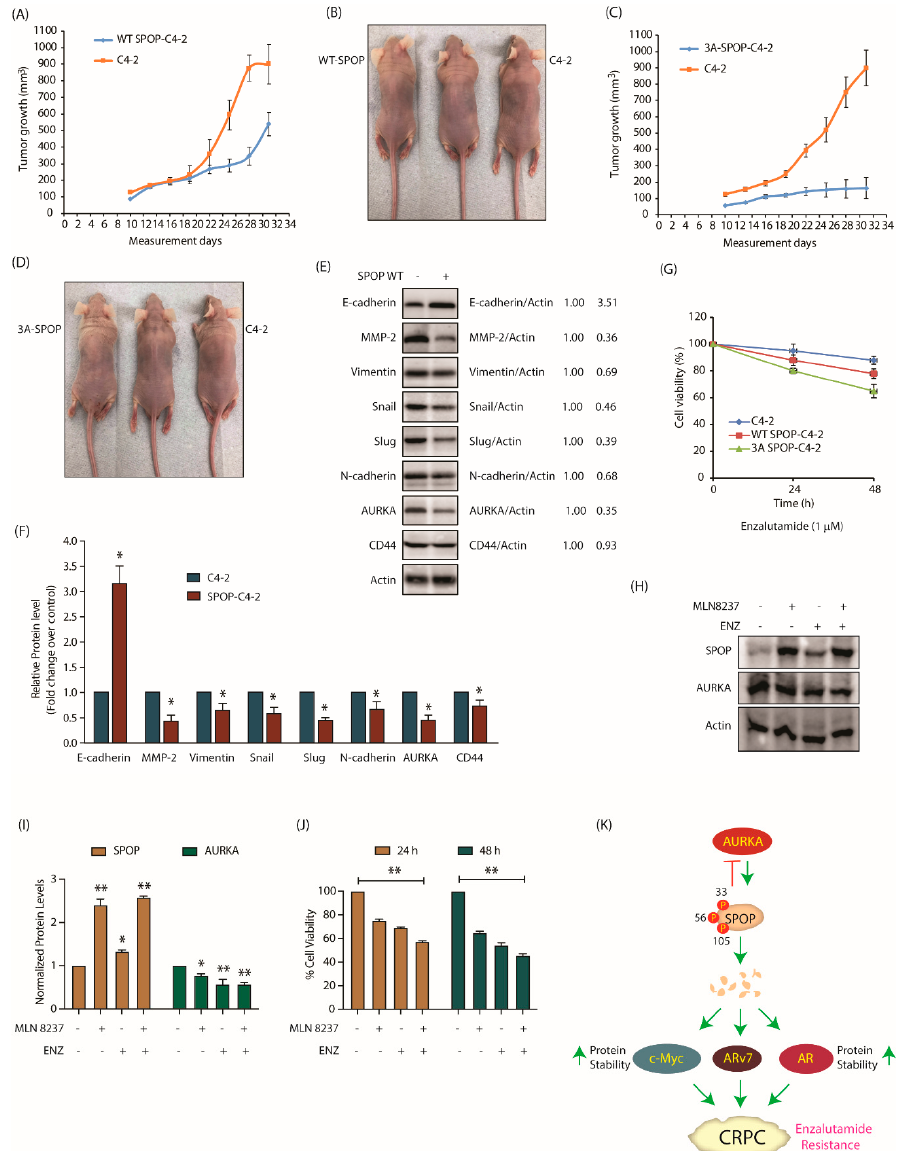
Figure 8. SPOP degradation by AURKA promotes tumorigenesis, EMT and enzalutamide-resistance. ( A ) SPOP overexpression prevents tumor growth in vivo. Growth curves of tumor in nude mice inoculated with C4-2 and SPOP-C4-2 cells on right and left shoulders, respectively. The mean value ± SEM values were from three animals in each group. ( B ) Representative images of tumor bearing nude mice. Pictures were taken 32 days after injection. ( C ) Growth curves of tumor obtained from nude mouse injected with C4-2 and 3A-SPOP-C4-2 cells. ( D ) Representative image showing mouse with tumor. The pictures were taken 32 days following inoculation. ( E ) Expression of EMT markers in tumor tissues obtained from C4-2 and SPOP-C4-2 cells injected in mice. ( F ) Histogram shows expression levels of EMT markers in tumor isolated from C4-2 and SPOP-C4-2 injected mice. The data are presented as mean ± SEM values collected from three independent experiments. * p < 0.05 was analyzed using two-way ANOVA. ( G ) 3A-SPOP-expressing cells are more sensitive to enzalutamide (1 µ M, treated for 48 h), compared to WT-SPOP-C4-2 cells. ( H ) Changes in SPOP levels with treatments of MLN8237 (1 µ M, treated for 12 h), and enzalutamide (1 µ M, treated for 12 h). ( I ) Quantification of protein levels as a function of drug treatment obtained from three independent experiments, * p < 0.05, ** p < 0.01. ( J ) Loss of cell viability with treatments of MLN8237 (1 µ M, treated for 24 and 48 h), and enzalutamide (1 µ M, treated for 24 and 48 h). Data obtained from three independent experiments, ** p < 0.01. ( K ) Schematic model depicting the consequences of AURKA-SPOP signaling in CRPC